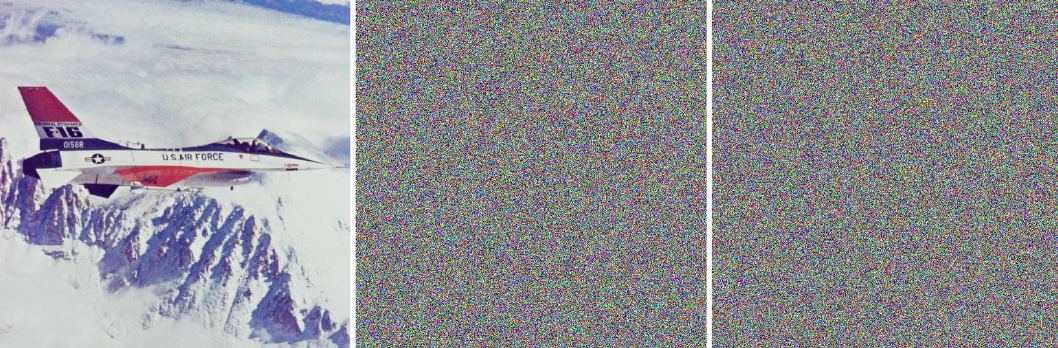
it. So let us try to restore the plain image from the imperfect encrypted image using the decryption method. Figs. 9 and 10 display the effects of occlusion and noise attacks in which the plain image is restored effectively after performing the decryption